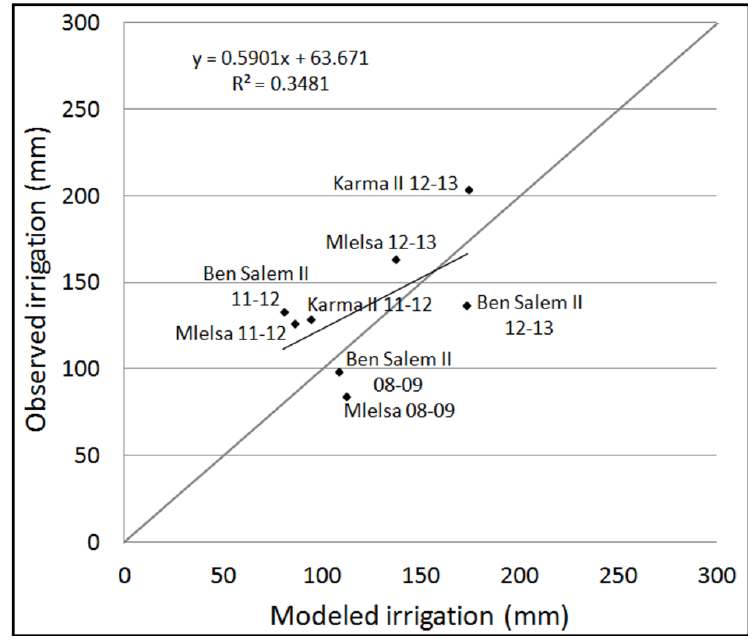
Figure 10. Comparison between observed and SAMIR modeled seasonal irrigation